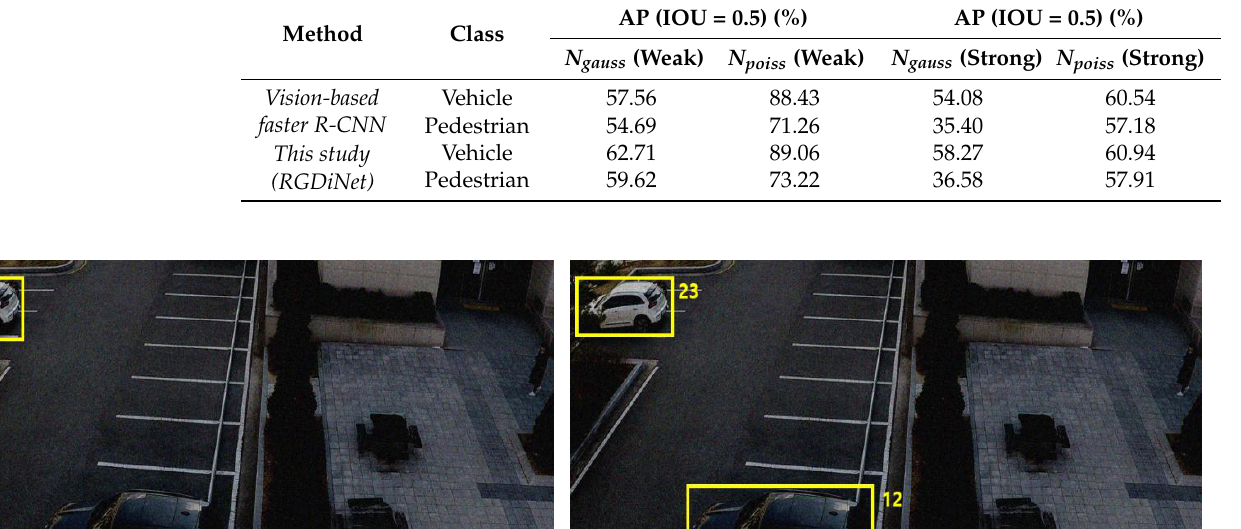
Table 4. Performance comparison of object detectors in noisy